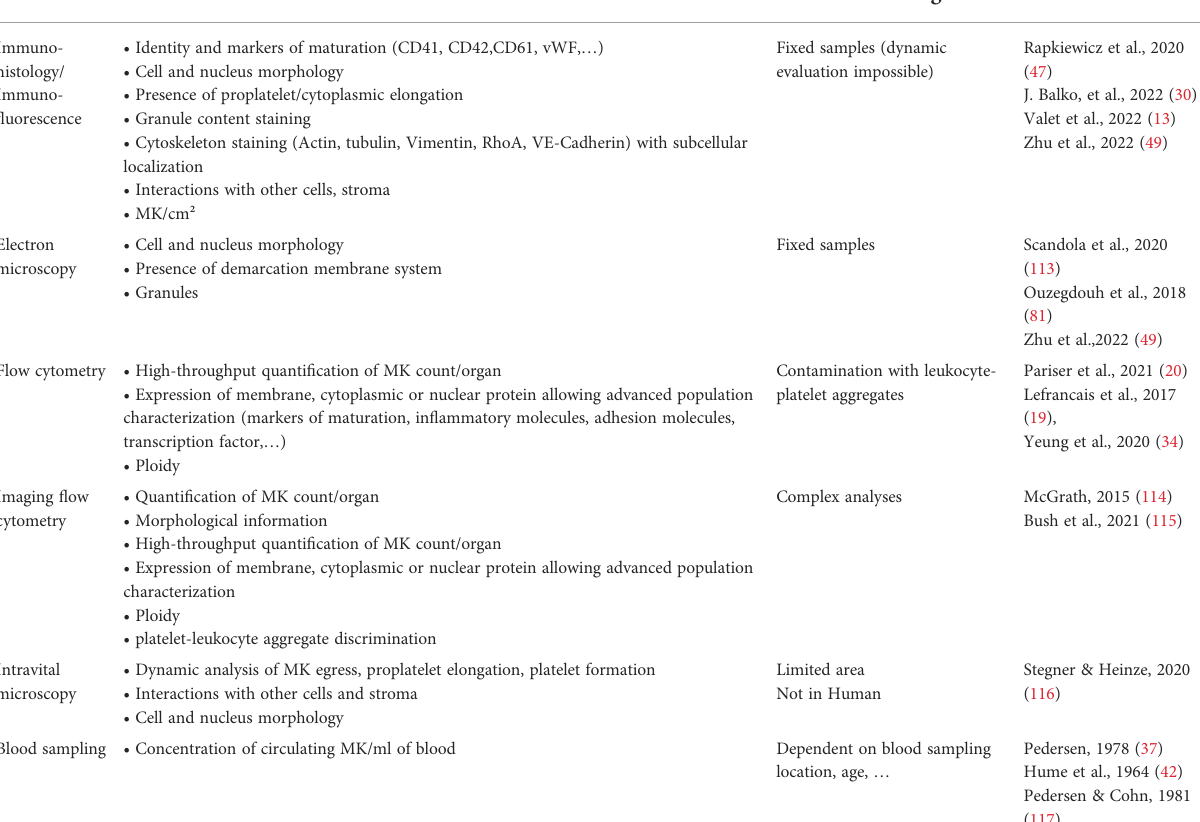
TABLE 2 Tool box for MK identi fi